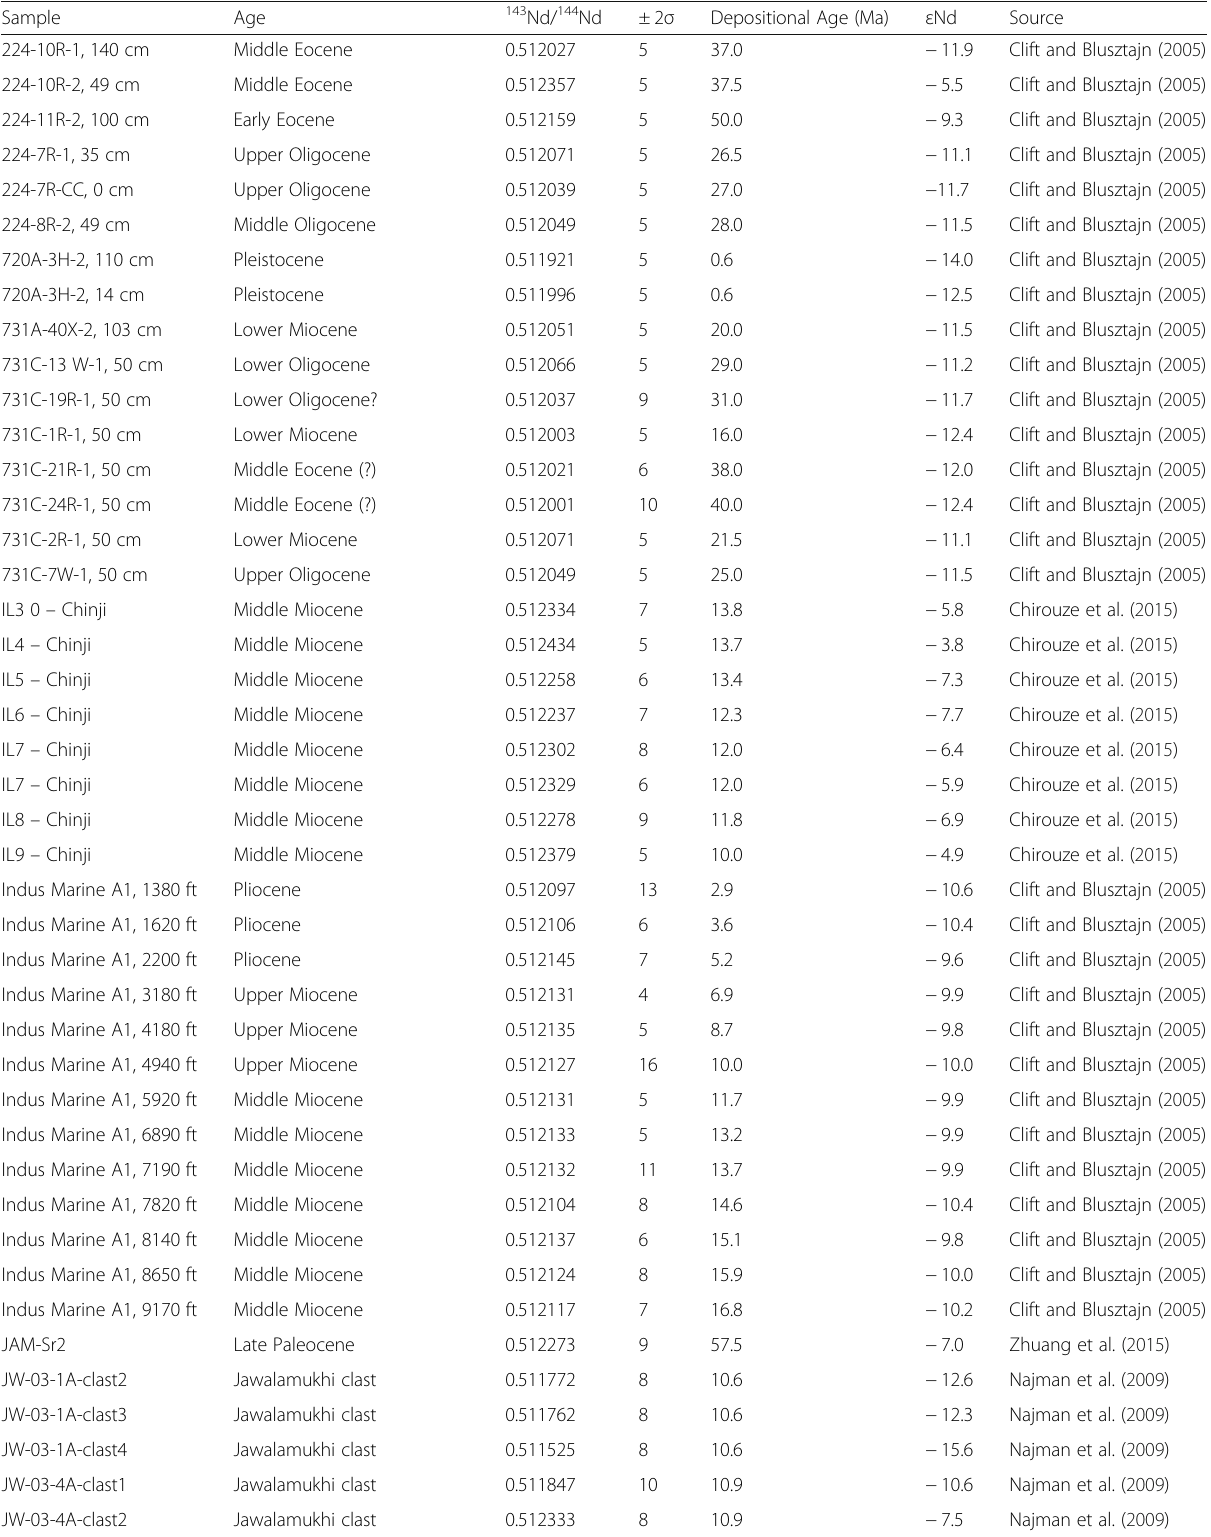
Table 1 Synthesis of published Nd isotope data used in this study, together with a reference to the original sources from which they were